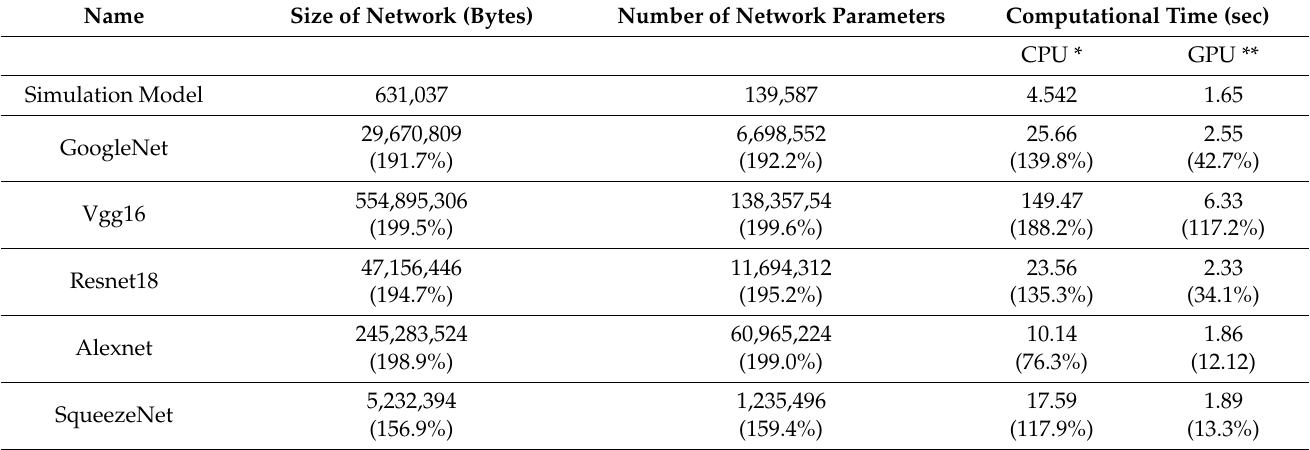
Table 3. Comparison of customized deep learning model with pre-existing deep learning